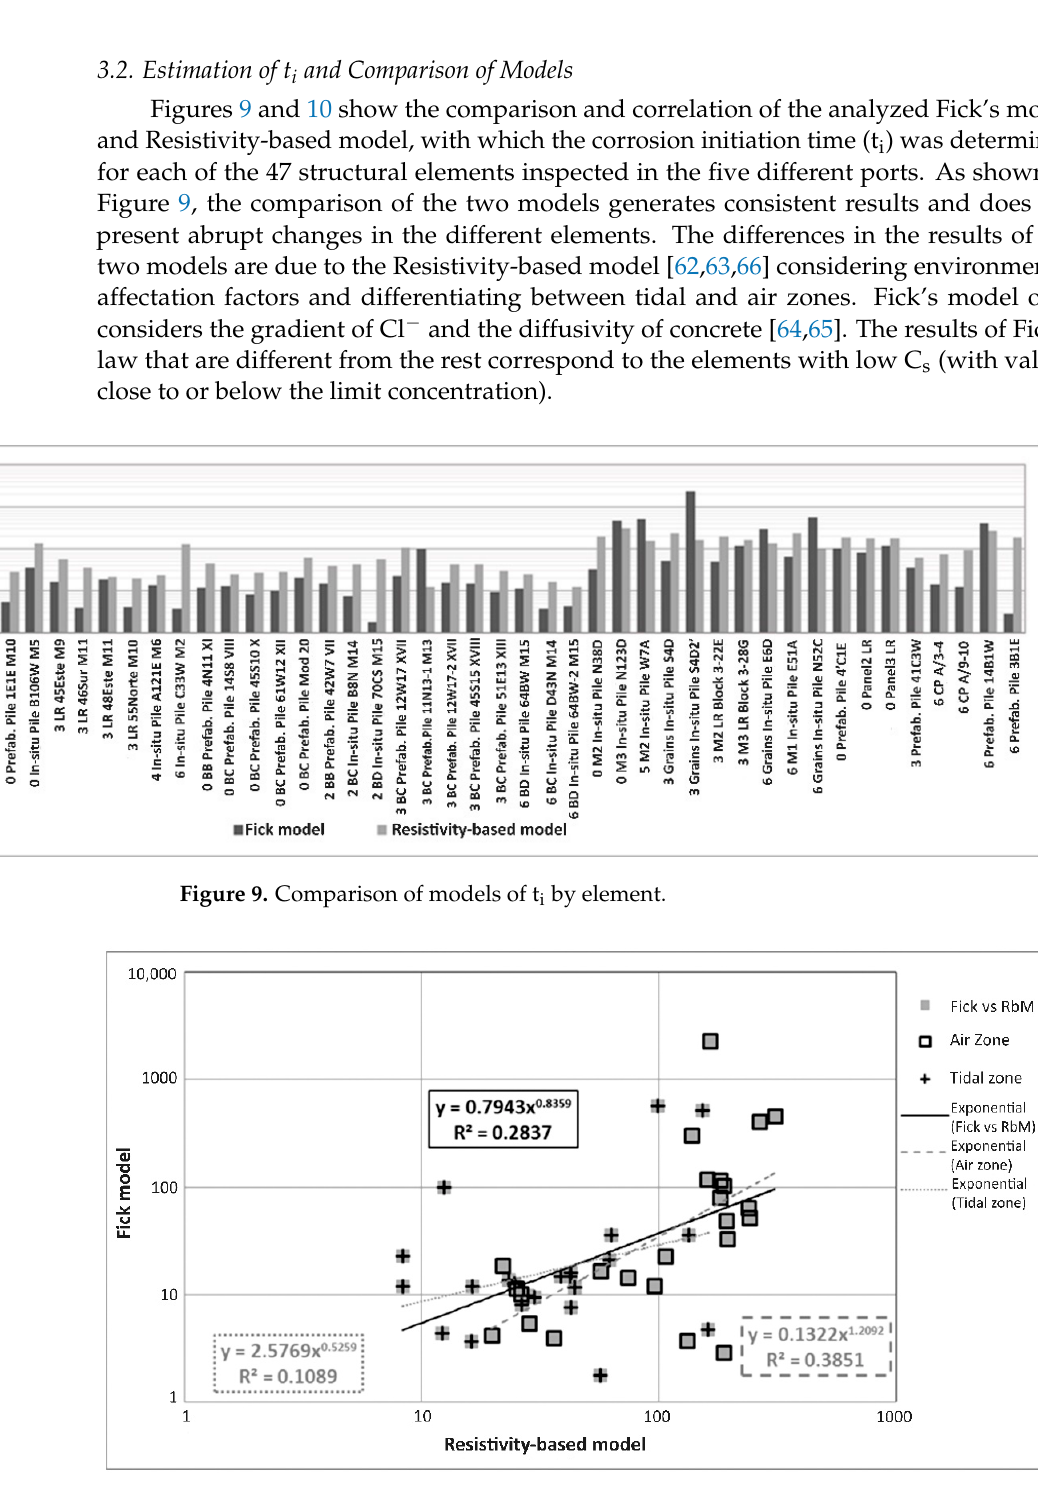
Figure 8. Effectiva porosity (EP) vs. compressive strength (fc).